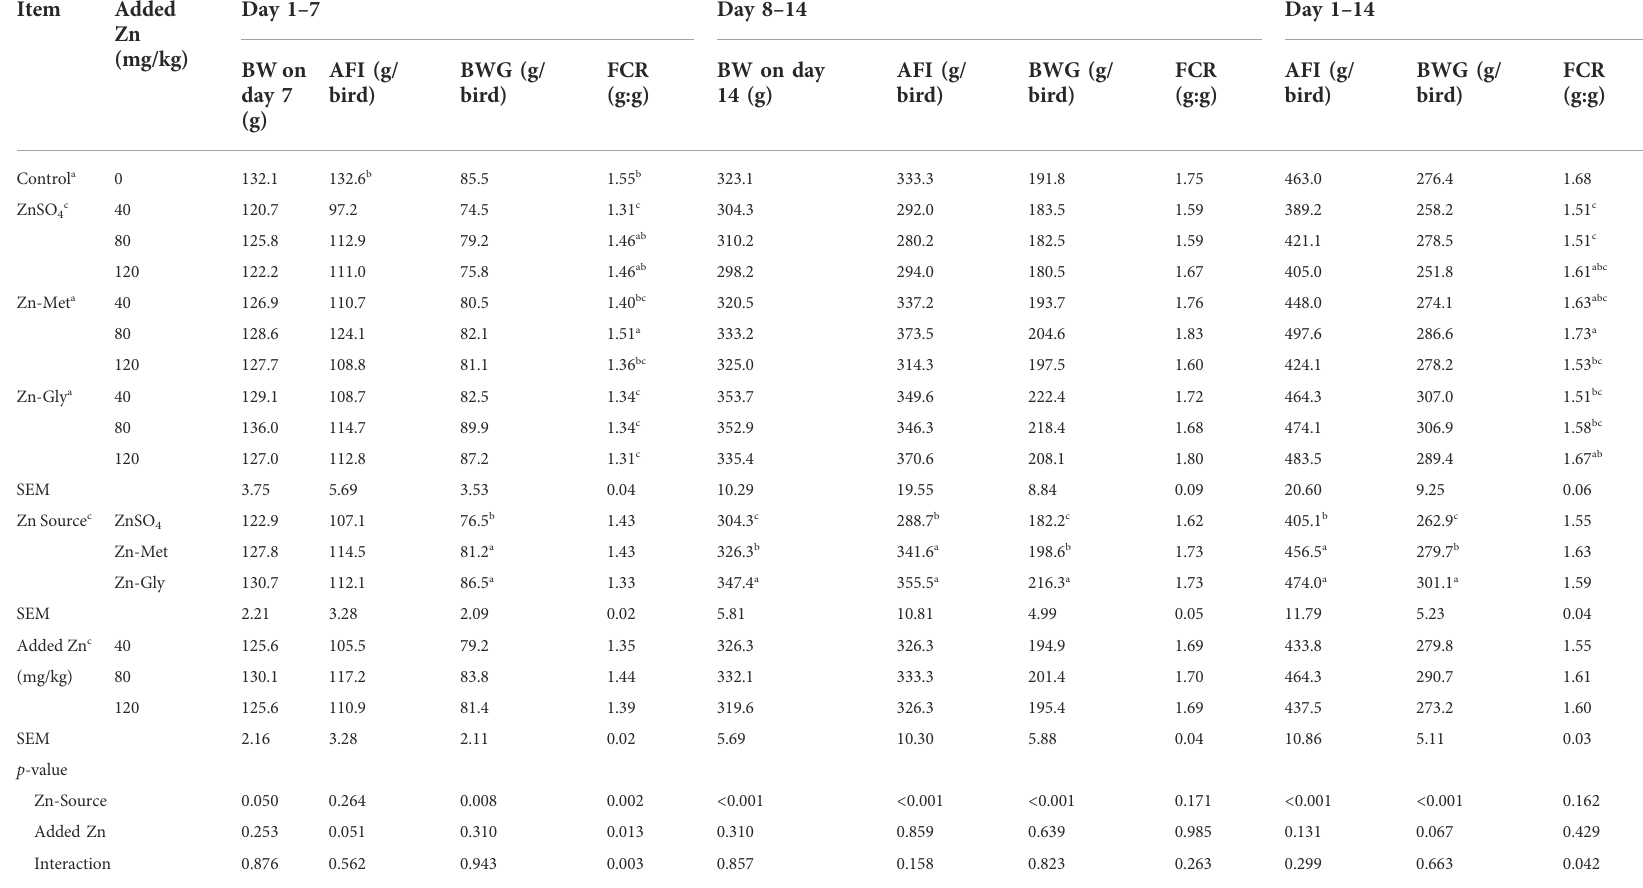
TABLE 3 Effects of supplemental zinc source and zinc level on the growth performance of broilers.